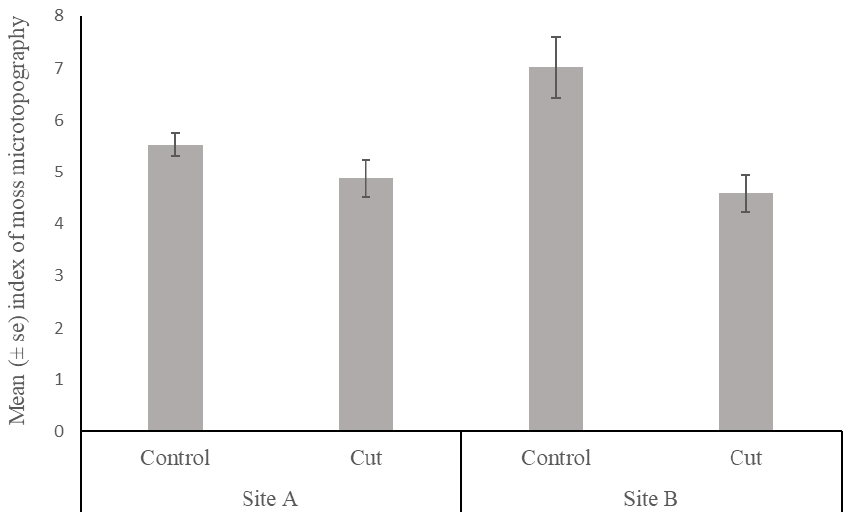
Figure 3. Mean (± SE) index of moss microtopography for cut and control plots on Site A and Site